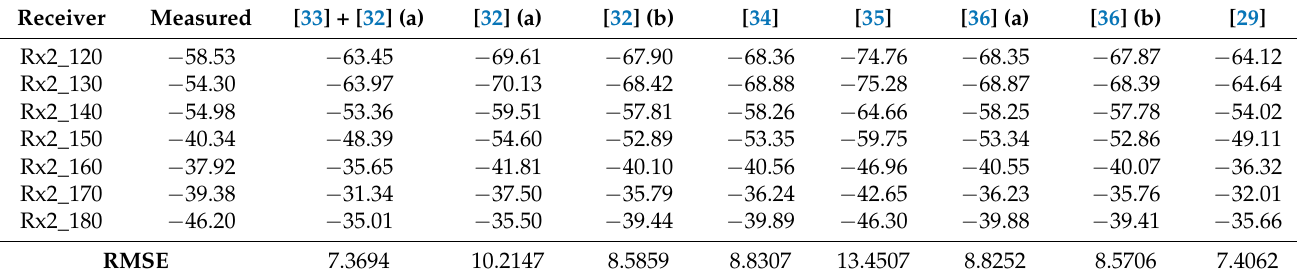
Table 4. Performance comparison between simulation and measurements at Rx2 (120–180 ◦ ) for two walls reflection